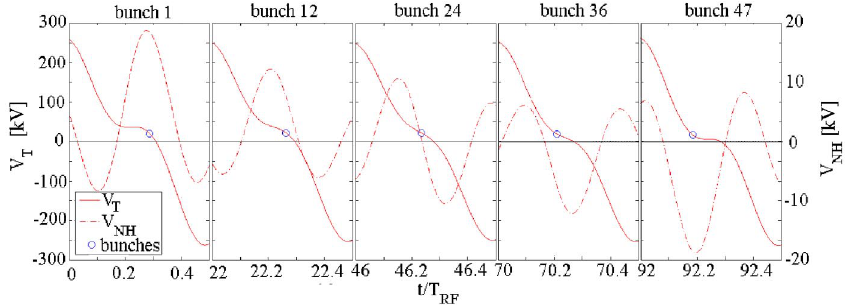
FIG. 9. (Color) Total voltage and the nonharmonic voltage on the bunches along the train with a gap.